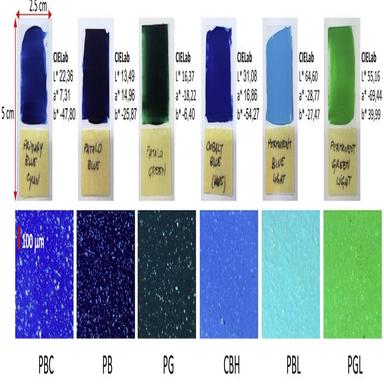
Copper phthalocyanine paint layers applied on glass coverslips (upper row) and micro-images (lower row, 740 × 550 μm2 ) showing paint micromorphology. CIEL\a\b\ values as measured through FORS analysis, are also reported (see text).